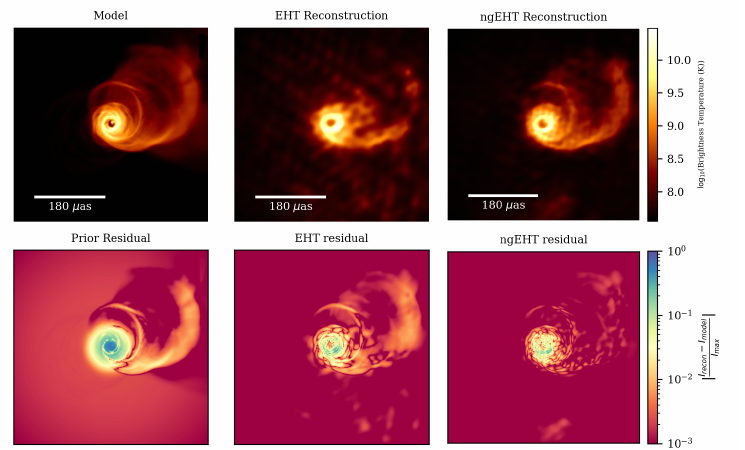
Figure 10. Top row: The model ( left ), EHT reconstruction ( middle ), and ngEHT reconstruction ( right ) 230 GHz images for the 1 April 2021 observations shown in Figure 7 of M87*. Bottom row: Plot of the normalized residual noise of the model with the prior ( left ), the EHT reconstruction ( middle ), and the ngEHT reconstruction. For these reconstructions, the ngEHT residuals in the faint jet region approach ∼ 10 − 3 of the maximum